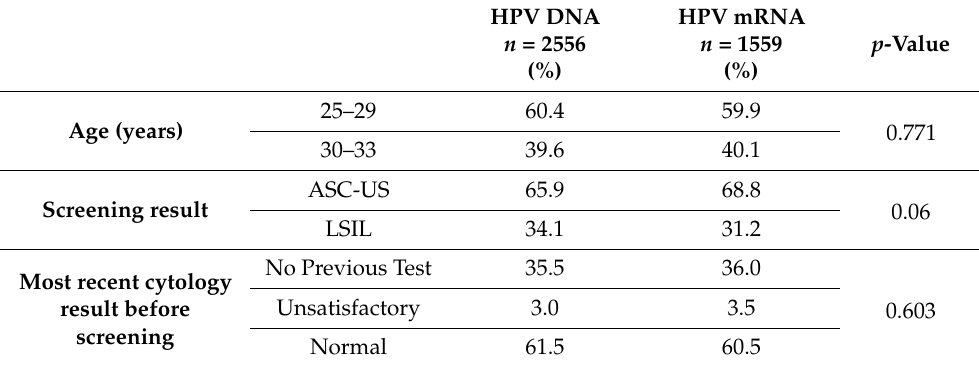
Table 1. Comparison of characteristics among HPV DNA-tested and HPV mRNA-tested women.